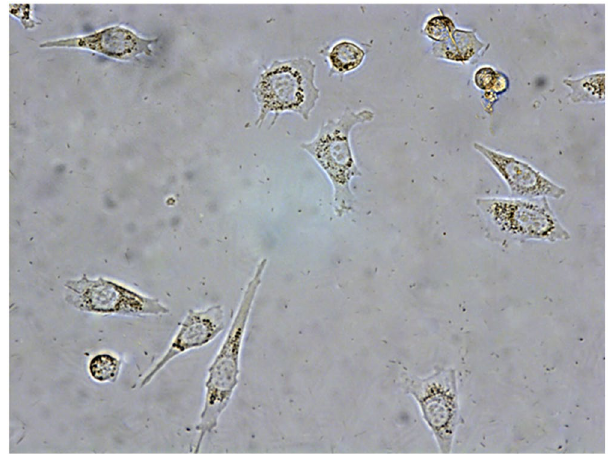
Figure 4. Microphotograph showing internalization of SHS- generated powder particles in A549 cells. Magnification: 360x.